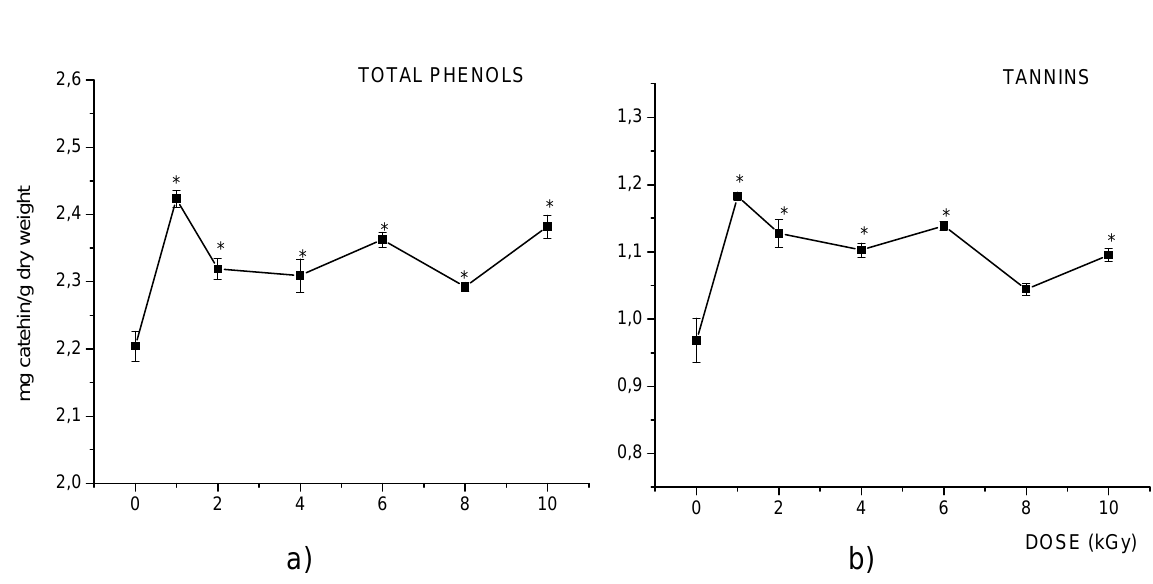
Figure 3. Effects γ -irradiation on total phenol (a) and tannin (b) contents in soybean seeds. Each data point represents the means; * ANOVA, Tukey-test, p < 0.05.